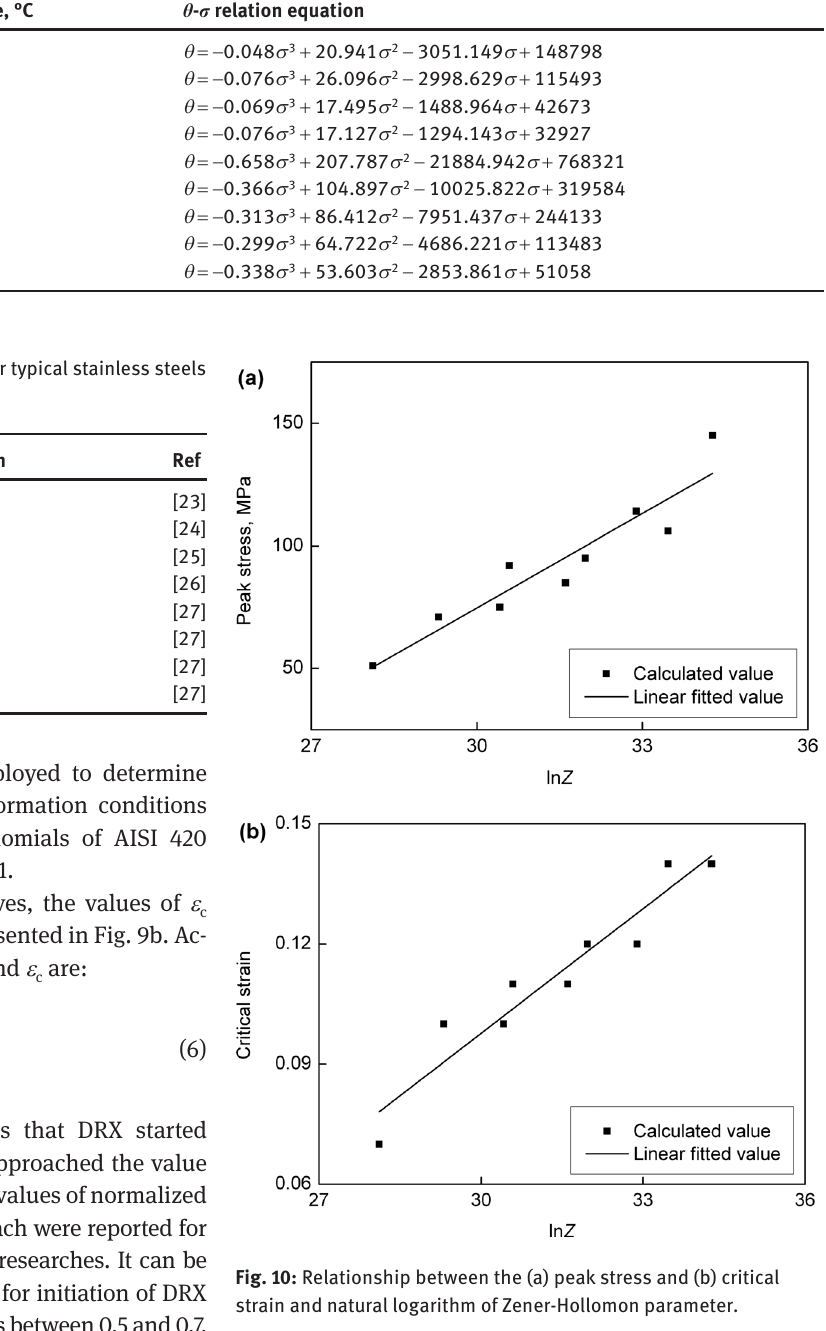
1. With decrease in deformation temperature, σ less obvious at strain rate of 0.1 s − 1 . The inflection point in the θ - σ plot was used to confirm the occur- rence of DRX.